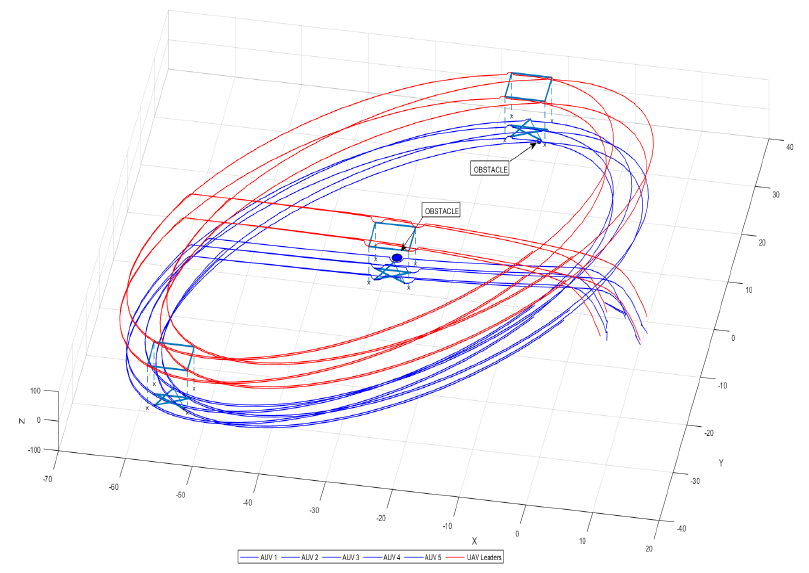
Figure 14. The containment maintenance of five AUVs in star formation within their four UAVs leaders in square formation during obstacles avoidance in 3D